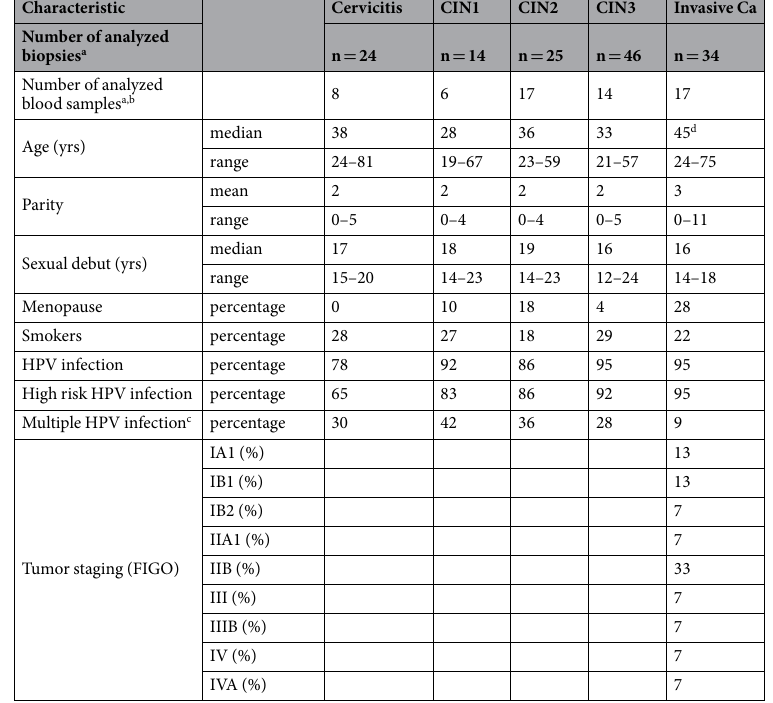
Table 1. Demographic data from patients enrolled in this study. a In each experimental group there was a varied proportion of patients from whom we were able to analyzed both the cervical biopsy and blood samples; b blood samples include PBMCs, neutrophils and plasma, not all samples were analyzed for all different parameters; c the multiple HPV infection group is a percentage of the total analyzed samples, and is included in the HPV positive infection group; d there was a significant positive correlation between age and lesion grade. Patients with cancer were significantly older than patients with other lesions (tested by one-way ANOVA, p = 0.03). Invasive Ca – invasive